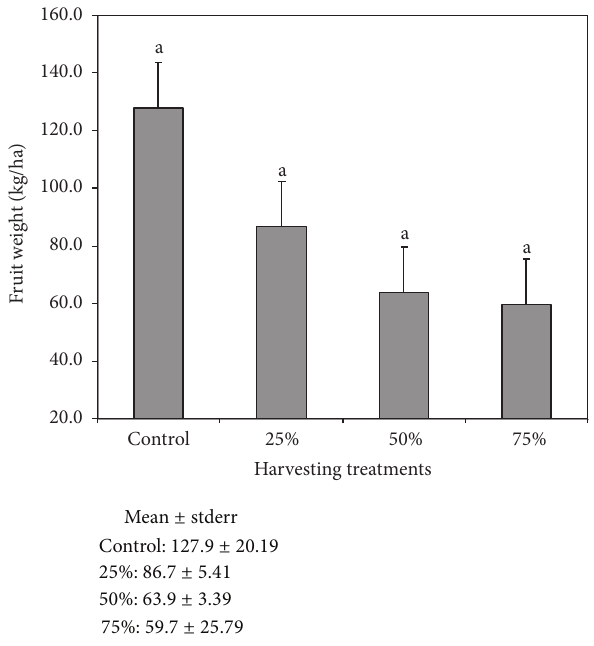
Figure 4: Effect of foliage harvest intensity on fruit weight of T. daniellii. Means ( ± SE) with similar letters do not differ significantly at 5% probability